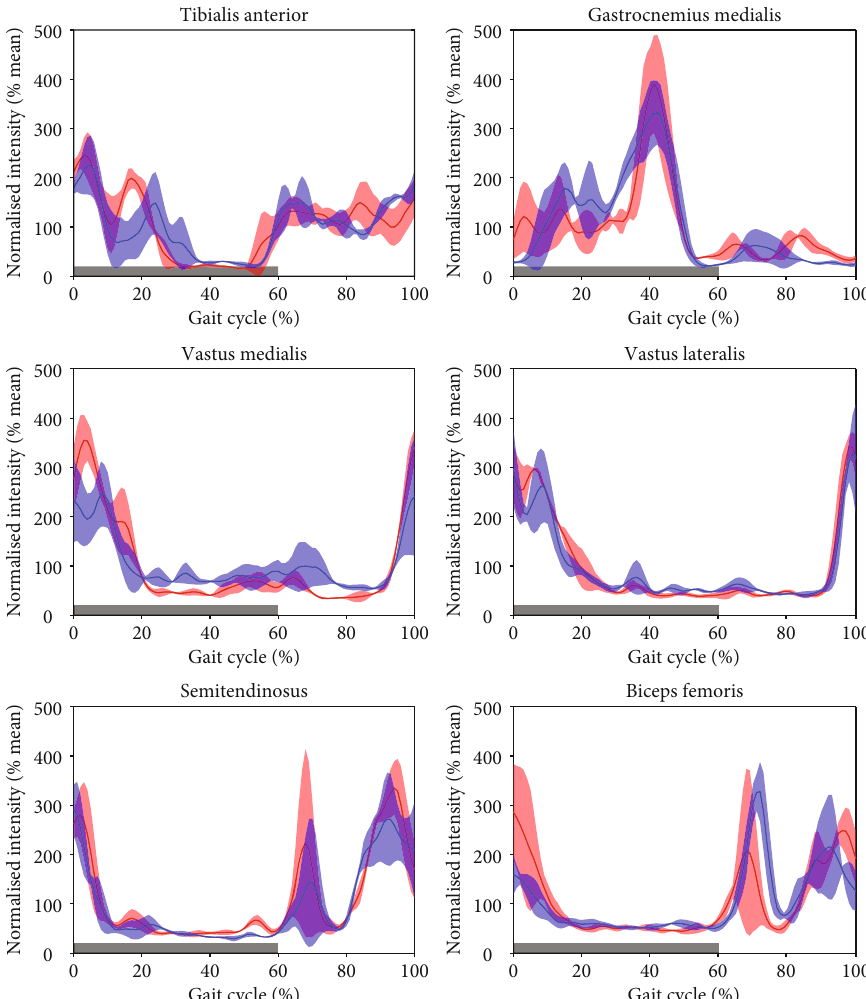
Figure 6: Relative muscle activity of selected lower extremity muscles during walking. Gait data was normalized to one gait